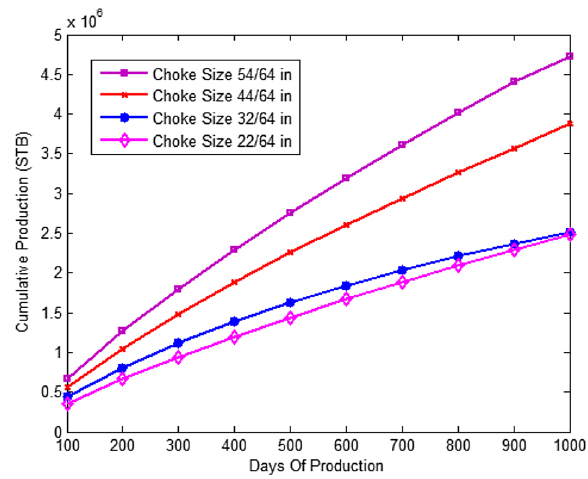
Fig. 21 Sensitivity analysis; effect of choke size on thickness of deposited asphaltene